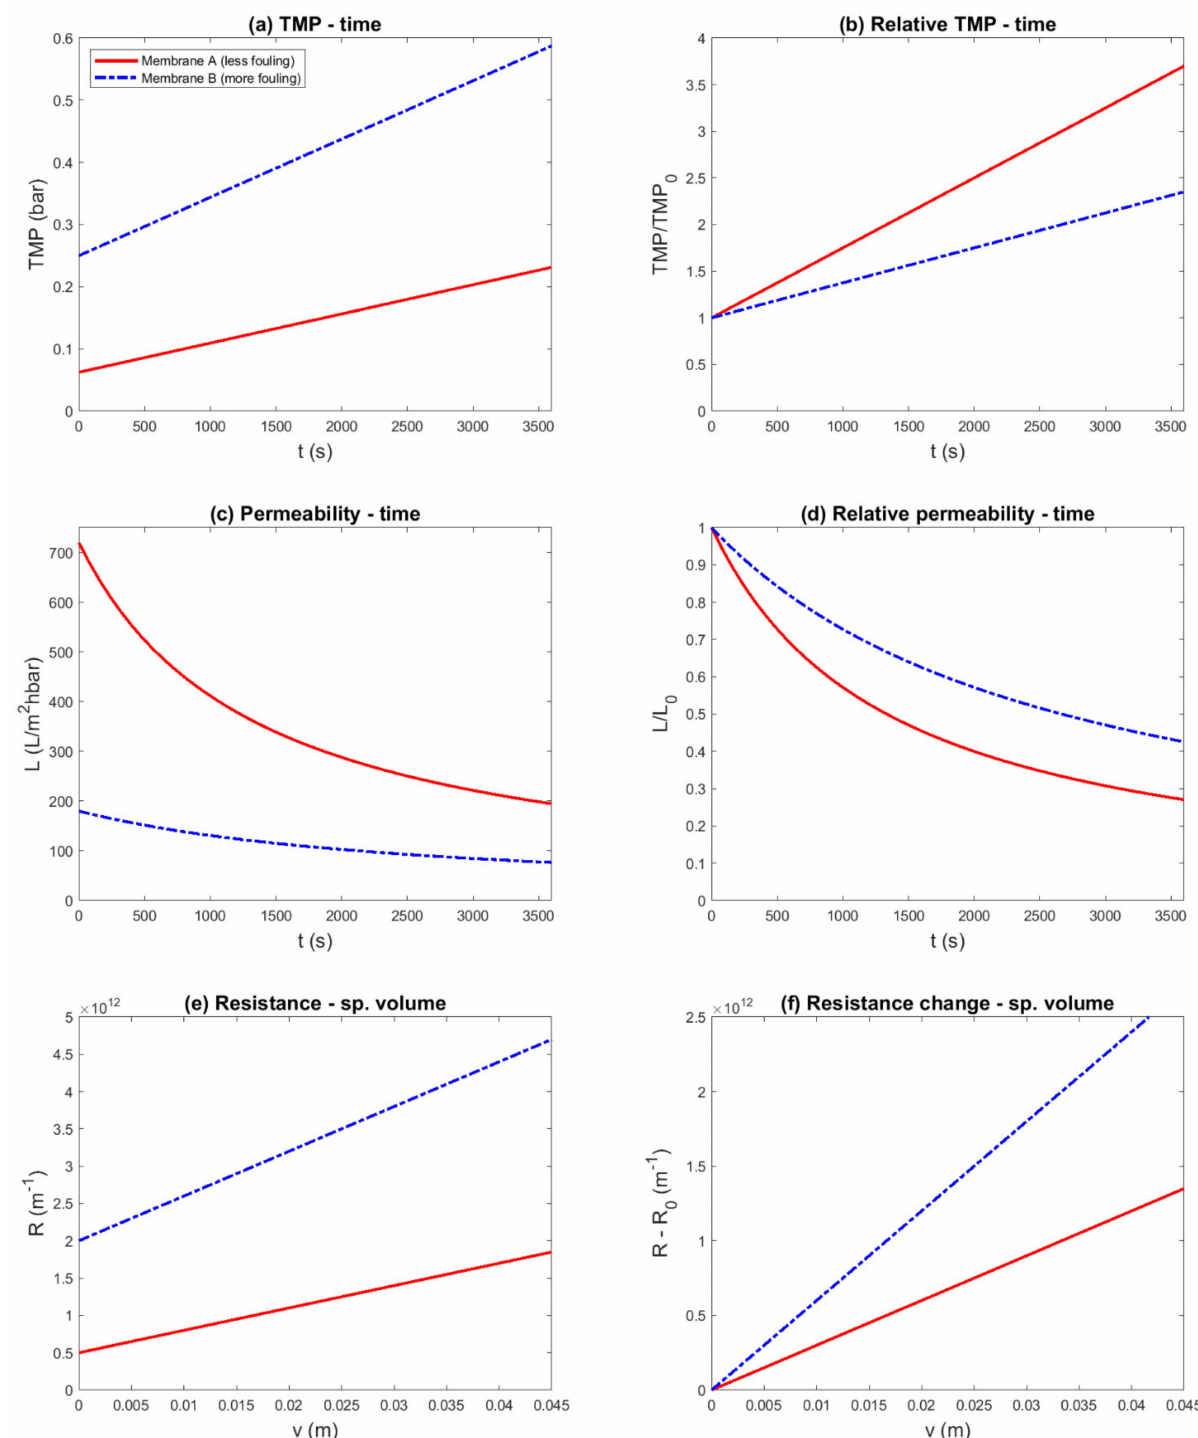
Figure 4. Simulated constant-flux experiment, aiming to compare two membranes. The example was constructed such that membrane A was superior to membrane B, due to both a lower membrane resistance ( R MA = 0.5 × 10 12 m − 1 vs. R MB = 2.0 × 10 12 m − 1 ) and a lower fouling rate ( α A = 3.0 × 10 13 m − 2 vs. α B = 6.0 × 10 13 m − 2 ). Different representations ( a —Transmembrane Pressure (TMP)–Time; b —Relative TMP–Time; c —Permeability–Time; d —Relative Permeability–Time; e —Resistance–Specific Volume; f —Resistance Change–Specific Volume) were compared to evaluate if the known difference in fouling propensity was correctly reflected: ( b , d ) suggest a conclusion contradicting the underlying